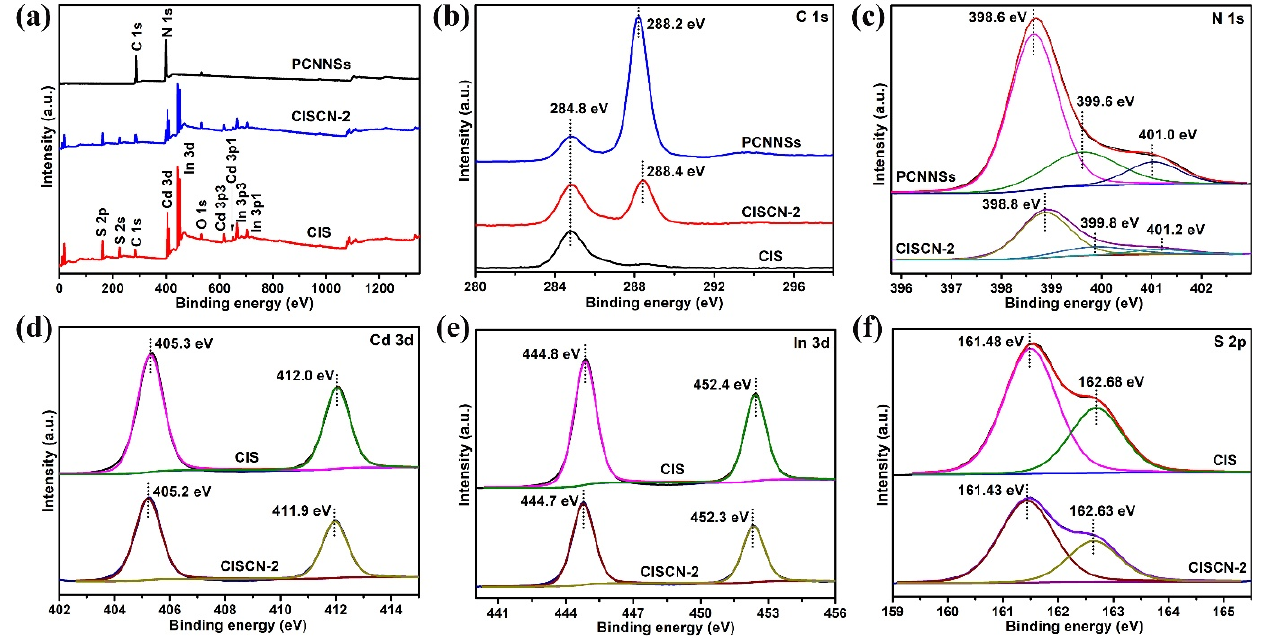
Figure 3. XPS spectrum of PCNNSs, CIS, and CISCN-2: ( a ) full-range spectrum, high resolution XPS spectra of ( b ) C1s, ( c ) N 1s, ( d ) Cd 3d, ( e ) In 3d, and ( f ) S 2p.